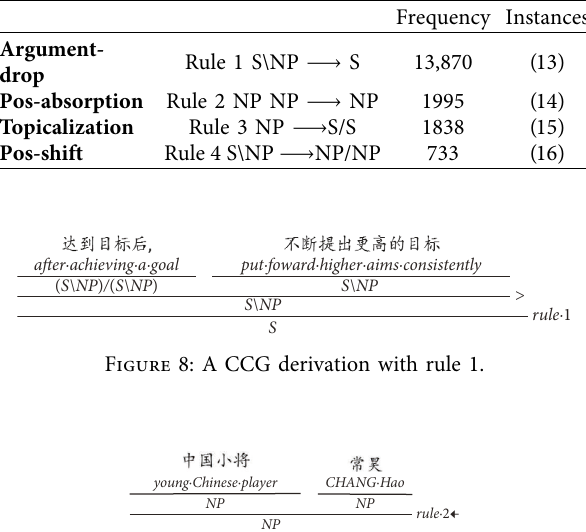
Figure 9: A CCG derivation with rule